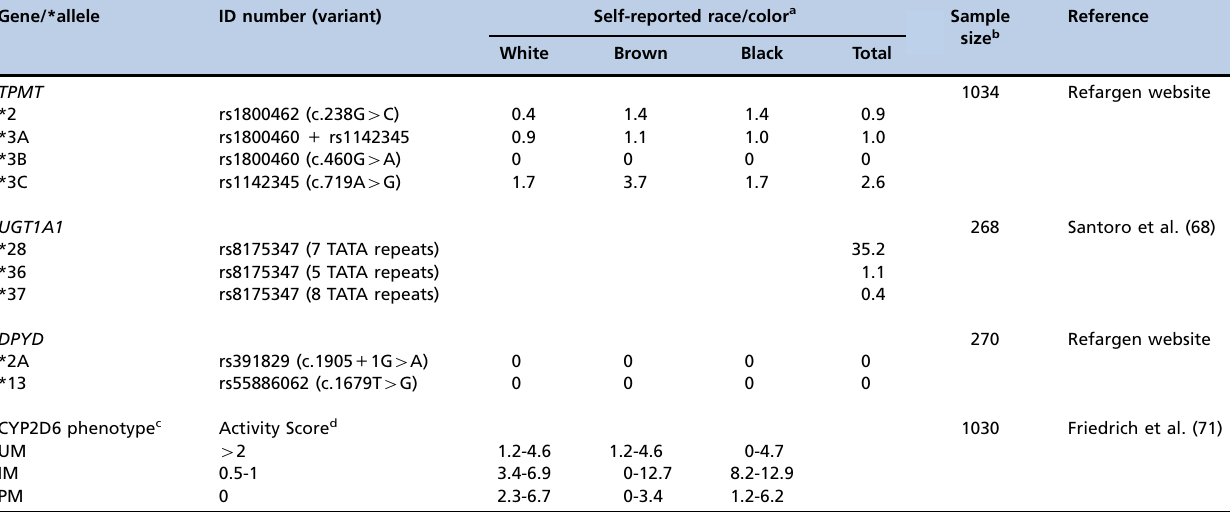
Table 2 - Frequency (%) among Brazilians of polymorphisms in pharmacogenes listed in the CPIC and DPWG guidelines for antineoplastic drugs.